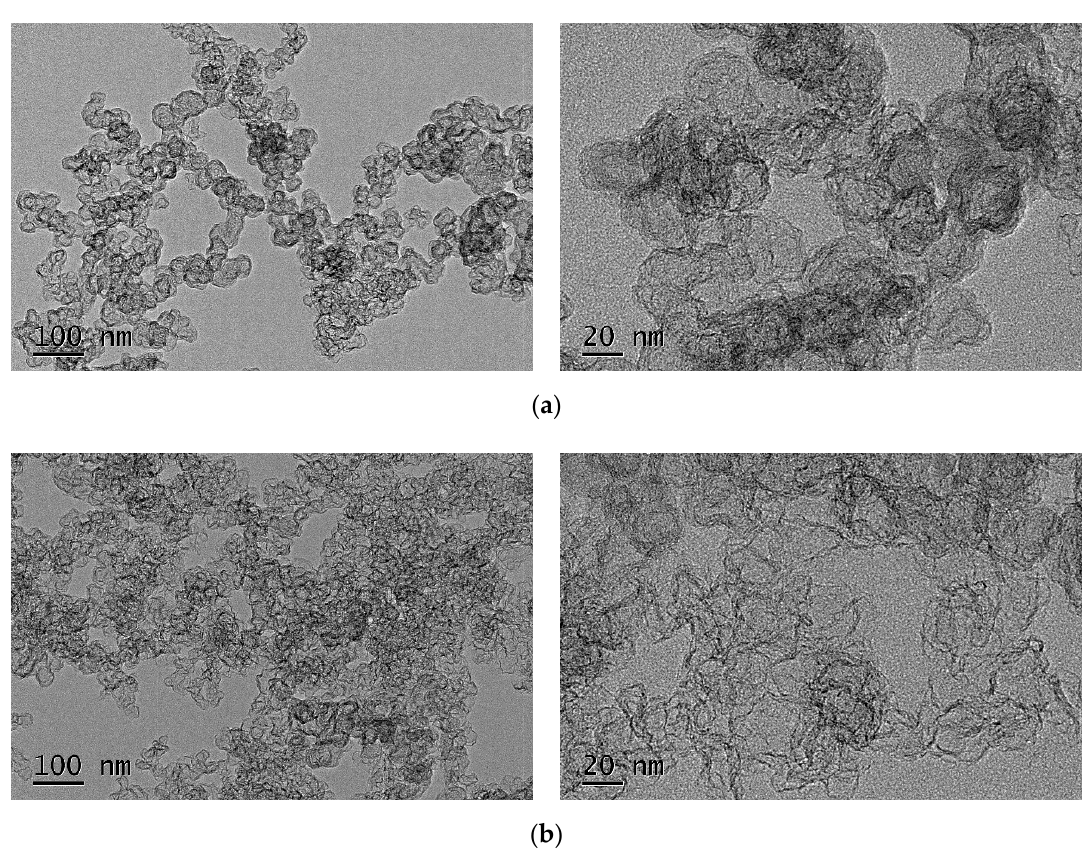
Figure 2. TEM images of ( a ) ECP600 and ( b ) B-ECP600.